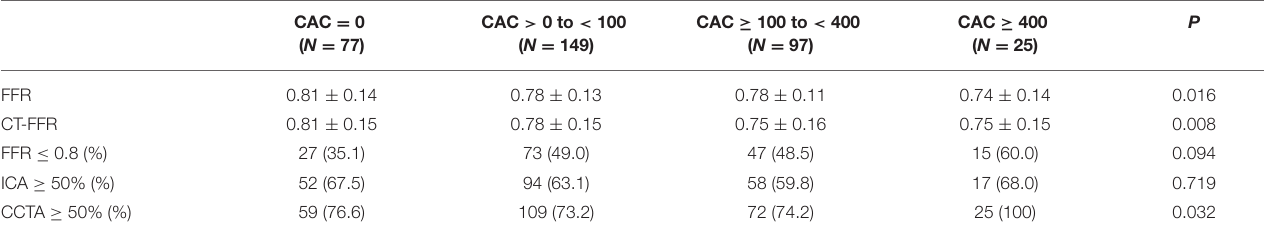
TABLE 2 | Results of CCTA, ICA, and FFR across CAC score categories in vessels.